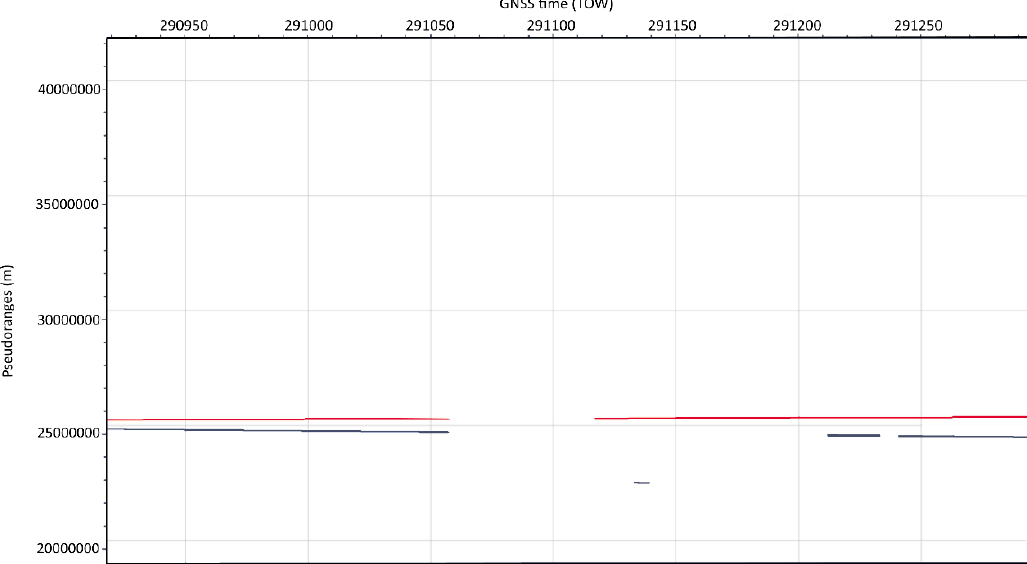
Table 2. Experiment I model summary ( 𝝍 = 0.75, C = 2).